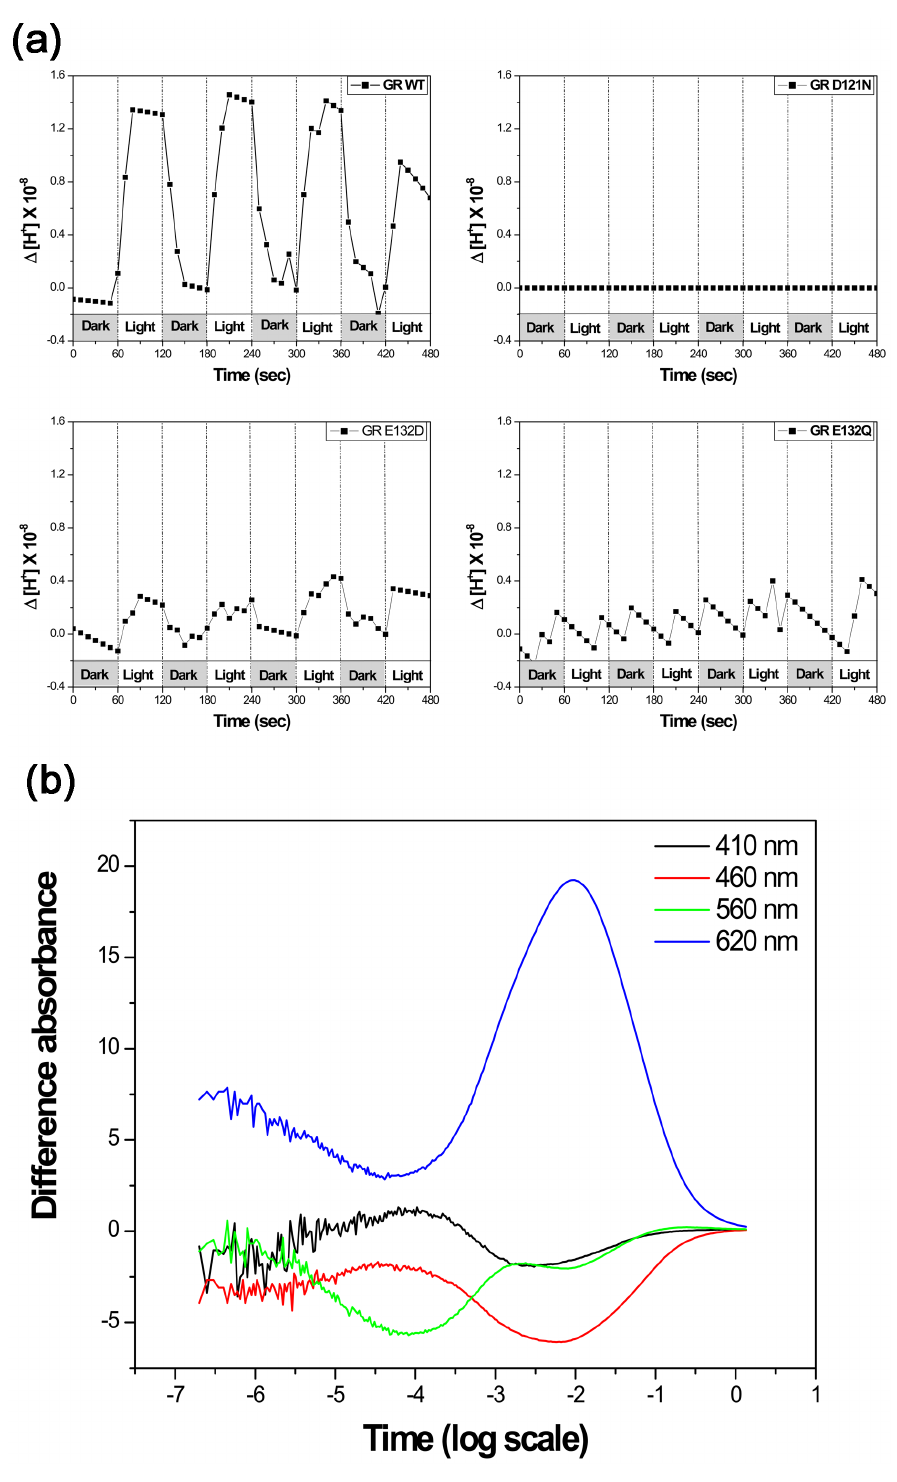
Figure 3. Proton pumping activity and photocycle kinetics. (a) Light induced proton fluxes in E. coli vesicles containing wild type and mutant GR. Initial pH values were adjusted to7. The buffering capacity was calibrated and the pH changes were recalculated into proton concentrations. (b) Photocycle kinetics of the wild-type GR measured in polyacrylamide gel-encased, DM-treated membranes at 22 u C, in 100 mM NaCl, 50 mM KH 2 PO 4 , pH 8. This figure gives overallcharacteristics of the photocycle with the differential absorption measured at 620 nm for theK and O intermediates, 410 nm for the M intermediate, 460 nm for the L intermediate, and 560 nm for the parent state and the N intermediate. See the full photocycle description in [20].